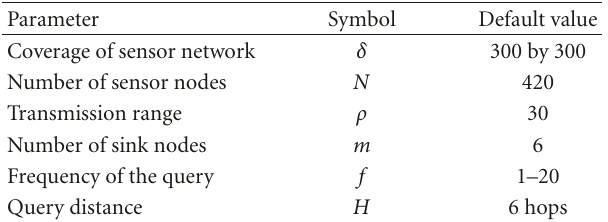
Table 1: Parameters of query and sensor